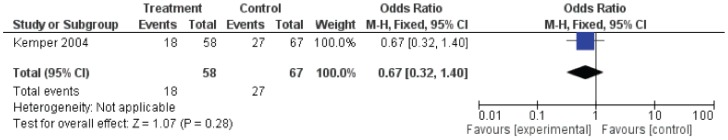
Analysis of reduction in IGA (pimecrolimus vs tacrolimus).